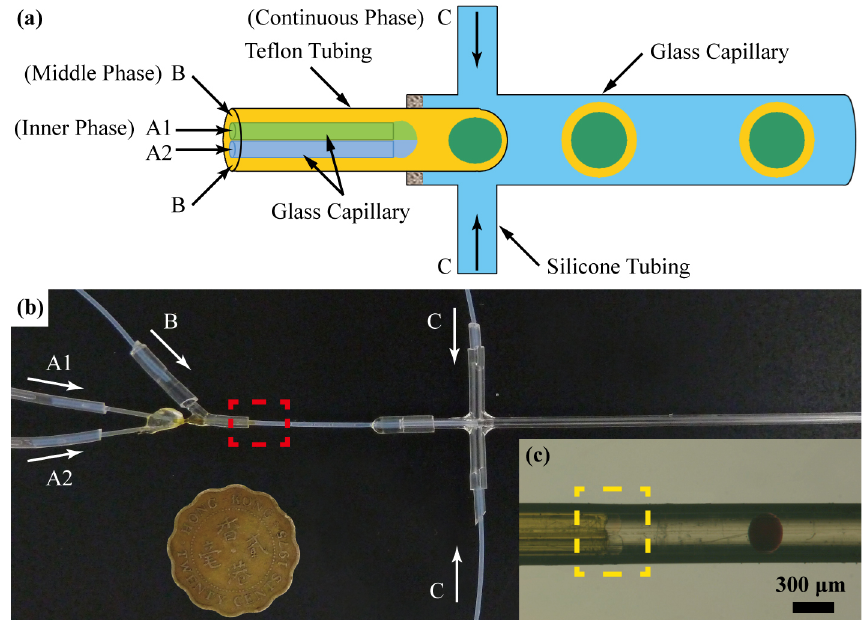
Figure 1. ( a ) Schematic illustration and ( b ) photograph of the plastic-glass hybrid microfluidic device with a Hong Kong 20-cent coin. ( c ) Optical microscope image showing the co-flow junction as highlighted with a red rectangle in (b). The reagent mixing between the two innermost aqueous streams of 0.27 M FeCl 3 and 1 M potassium thiocyanate (KSCN) for the innermost streams A1 and A2, respectively, within the yellow rectangle.